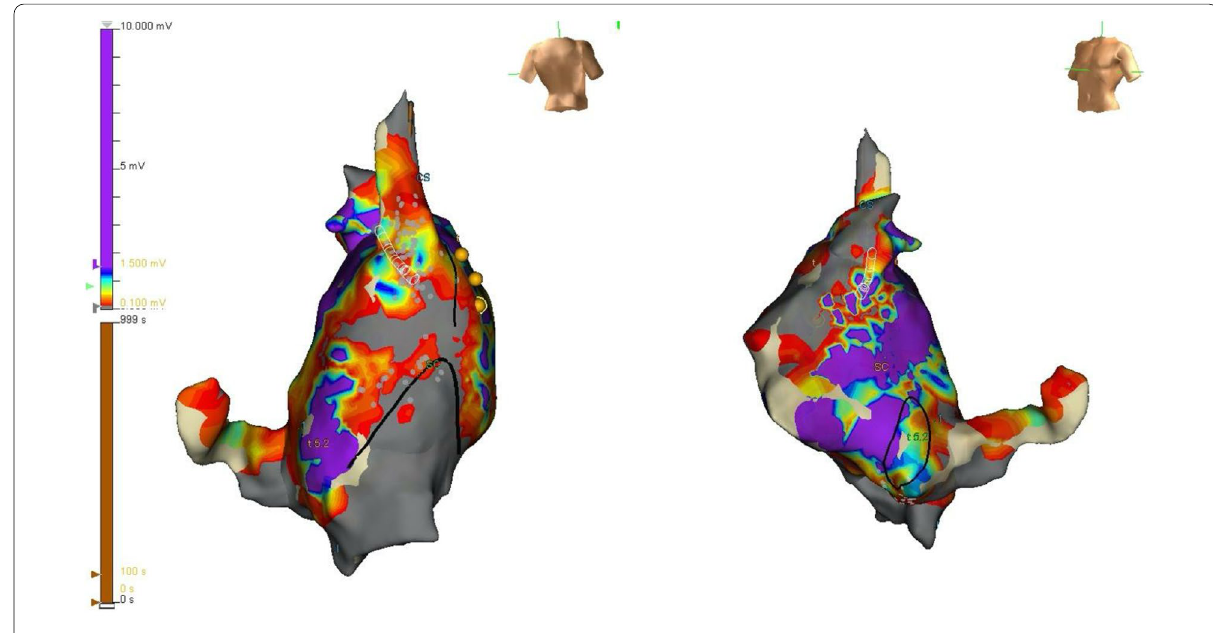
Fig. 2 The voltage mapping of the atrium revealed two areas with critically slow conduction. One located posterosuperiorly between right atrial wall scar and the superior vena cava and the second area was between the right side of atrioventricular groove and the inferior vena cava. The patient had history of tricuspid atresia, pulmonary stenosis, bilateral modified Blalock Shunt and Fontan Procedure